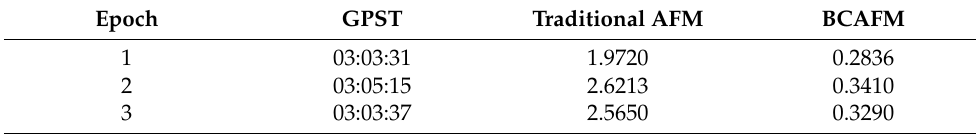
Table 2. The search time of AFM and BCAFM in three sample epochs. Epoch